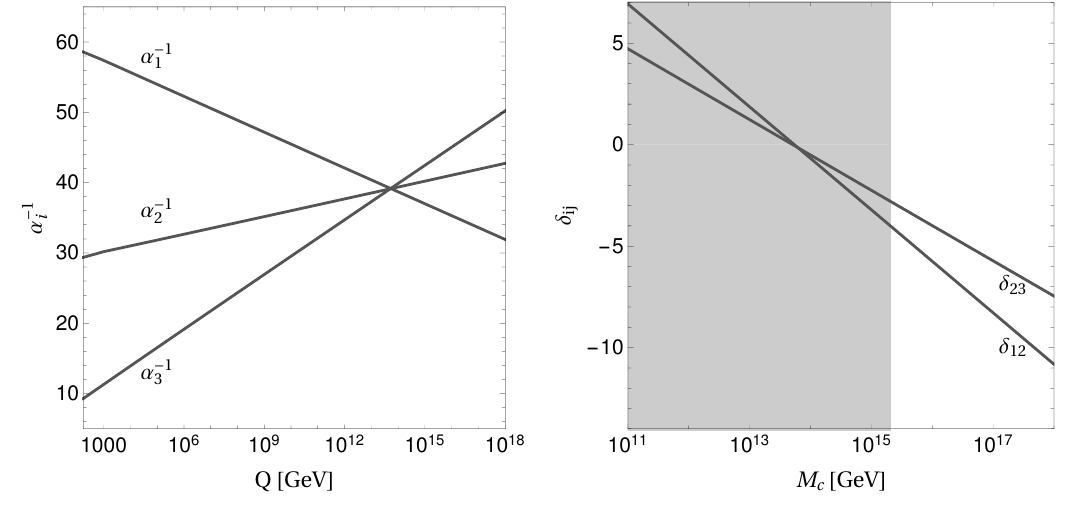
Figure 3 . Same as in (cid:12)gure 2, but for the case